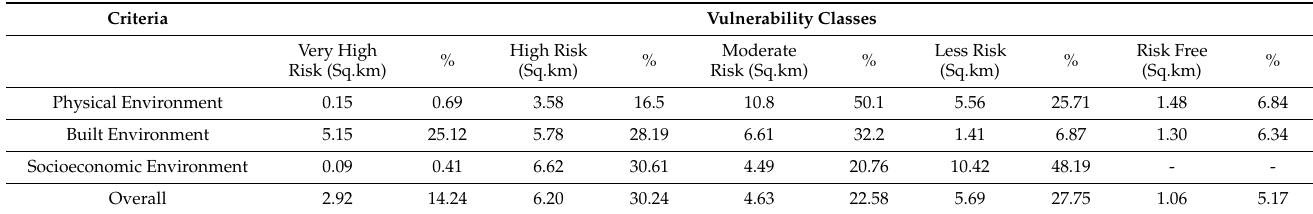
Table 7. Area coverage of flood vulnerability classes.